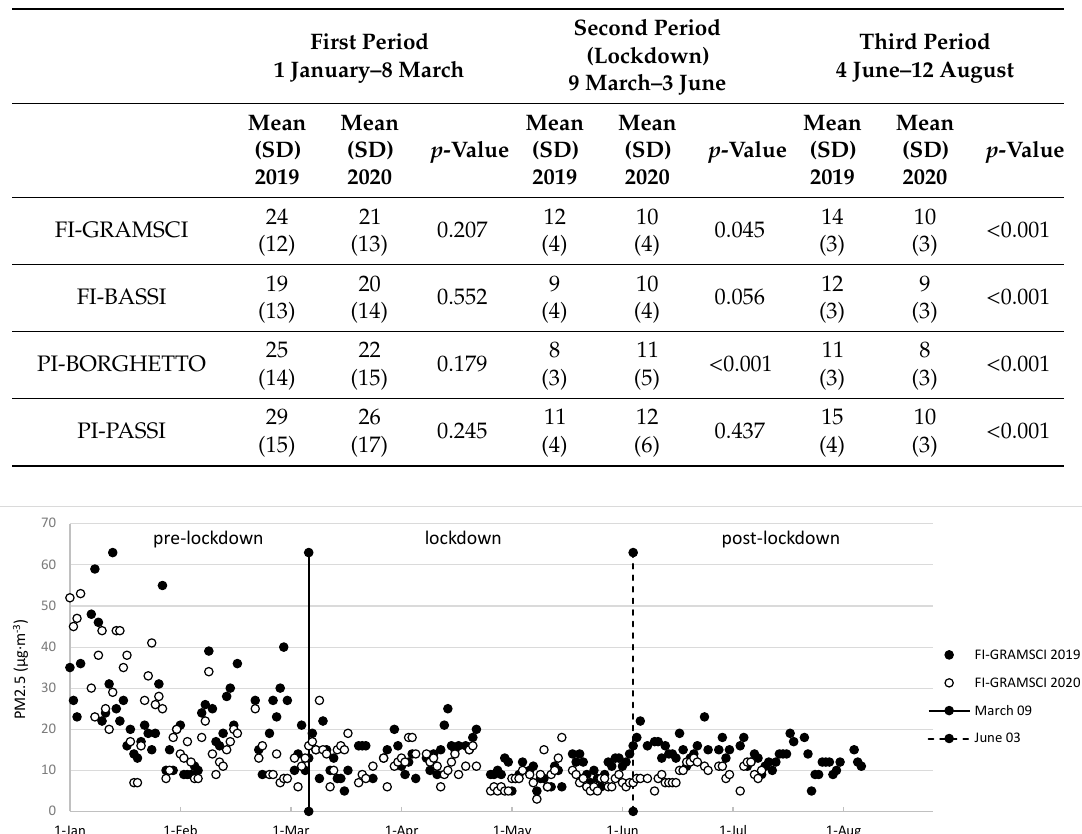
Table 3. Output of the two-sample t-test to evaluate the lockdown e ff ects on PM2.5 air concentration. The PM2.5 values are expressed in µ g · m − 3 .